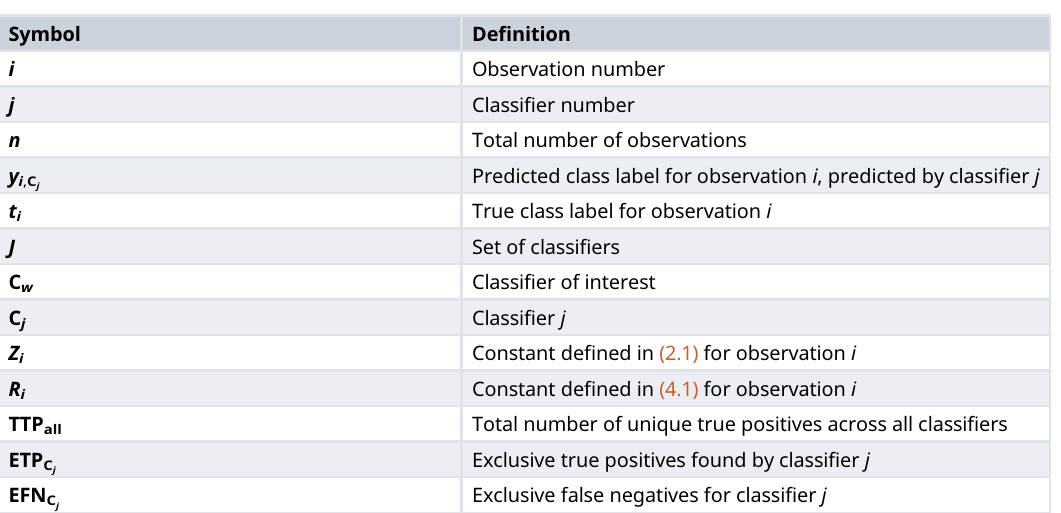
Table 1. Glossary of symbols